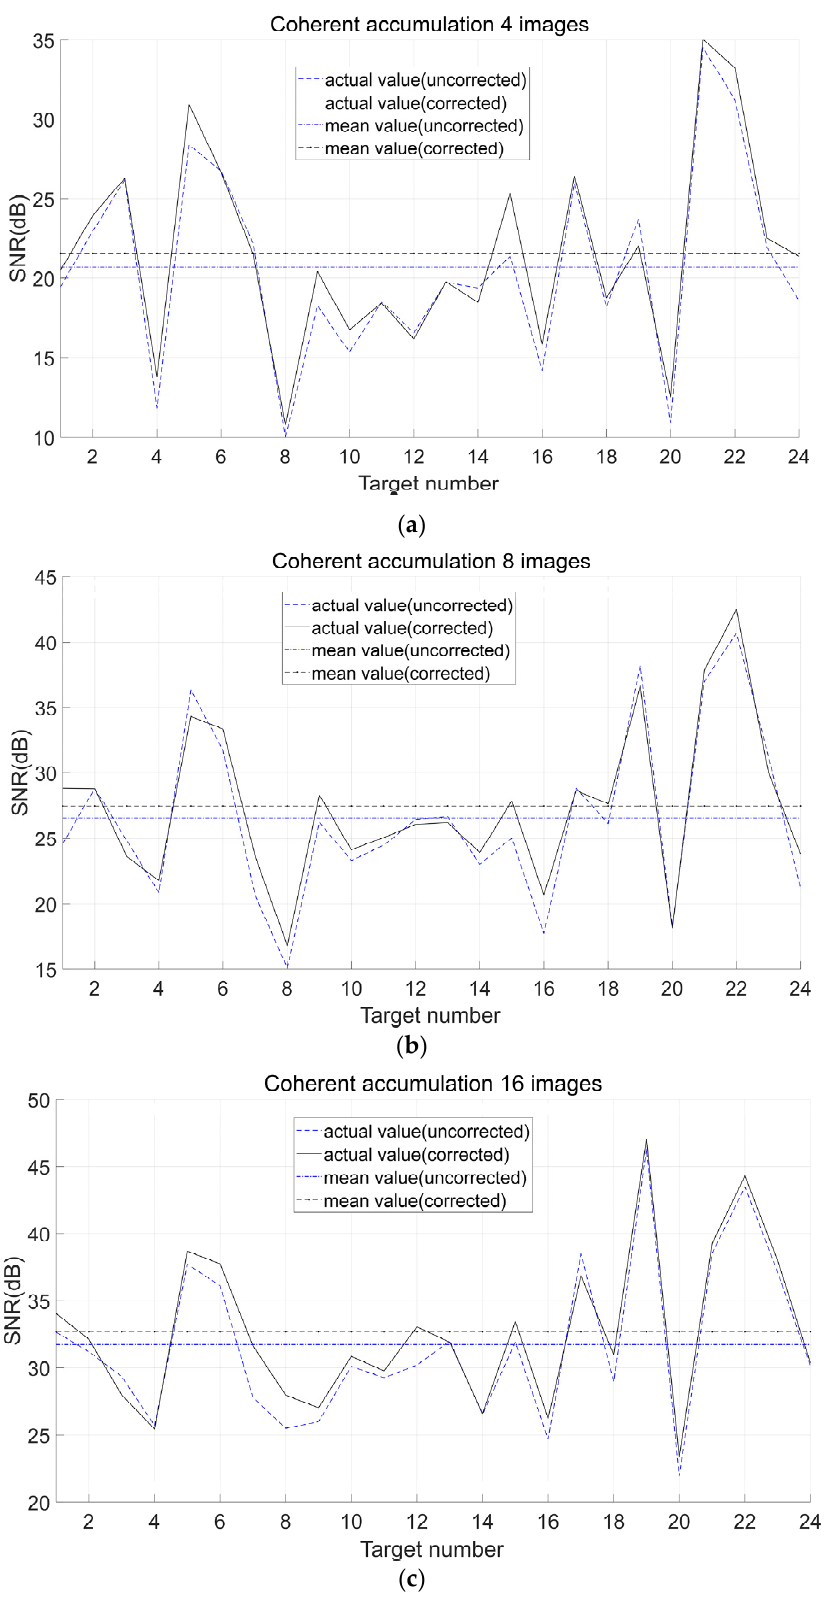
Figure 16. The comparison of target SNRs between uncorrected and corrected samples: ( a ) using 4 images; ( b ) using 8 images; ( c ) using 16